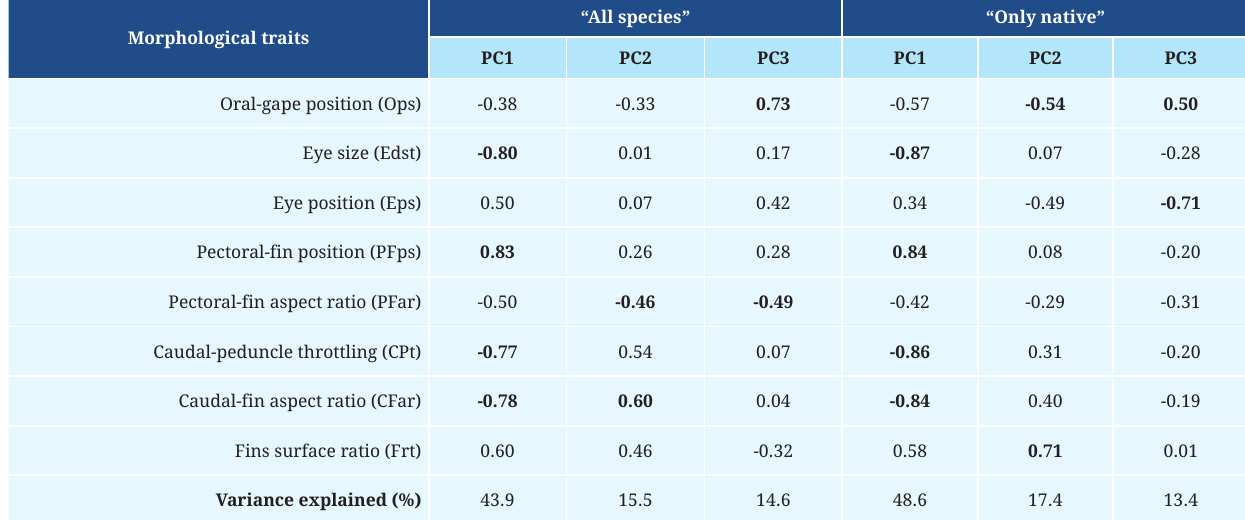
TABLE 2 | Correlation matrix between ecomorphological traits and each of the three axes of the PCAs representing the functional space of the two scenarios (“all species” and “only native”) of the fish assemblage from Carioca Lake, Middle Rio Doce basin. The most significant traits for each dimension are represented in